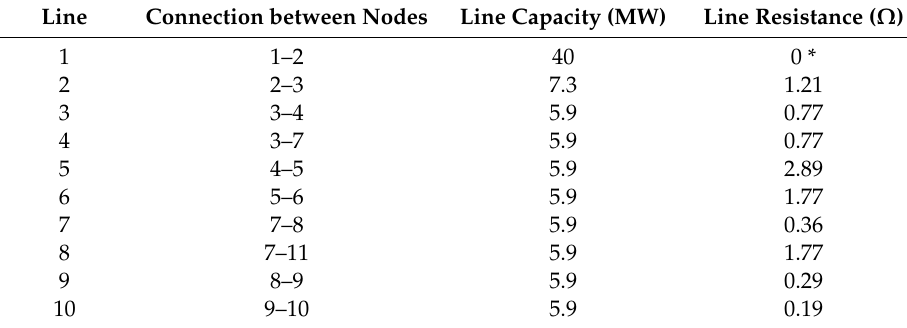
Table 2. Power lines parameters.